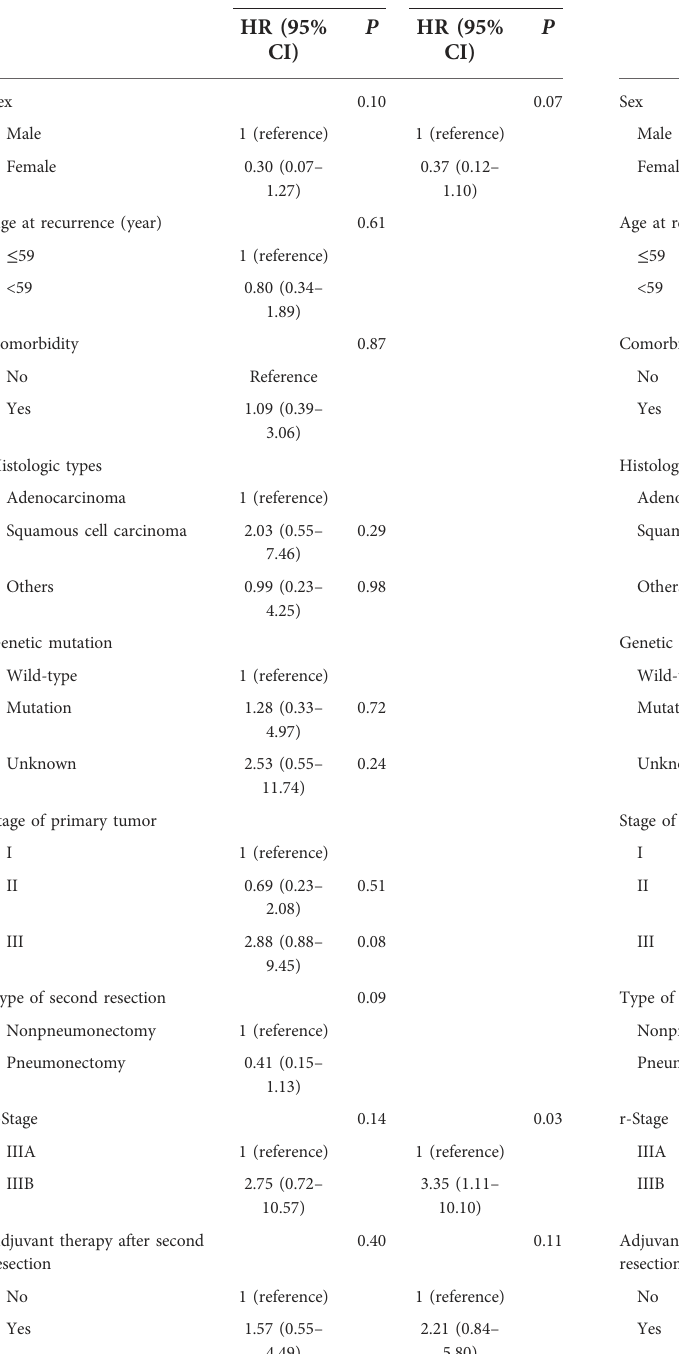
TABLE 4 Cox proportional hazards regression model showing the association of variables with OS fi gure